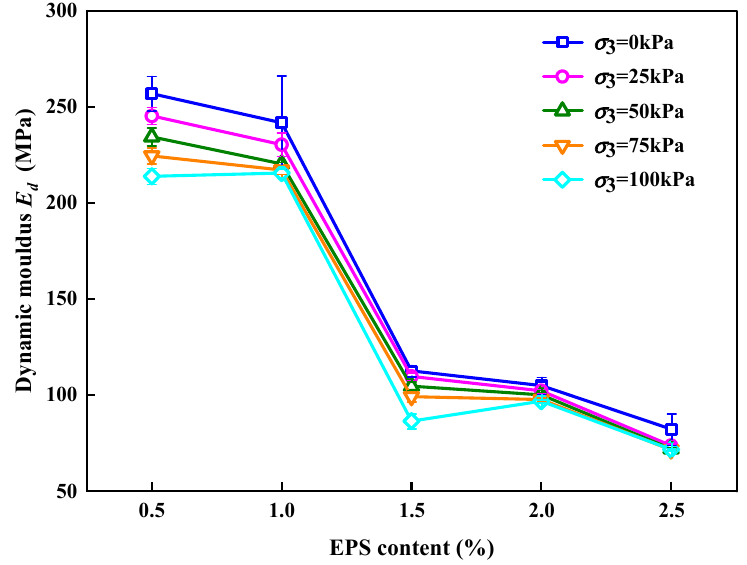
Figure 6. Relationship between EC and E d .